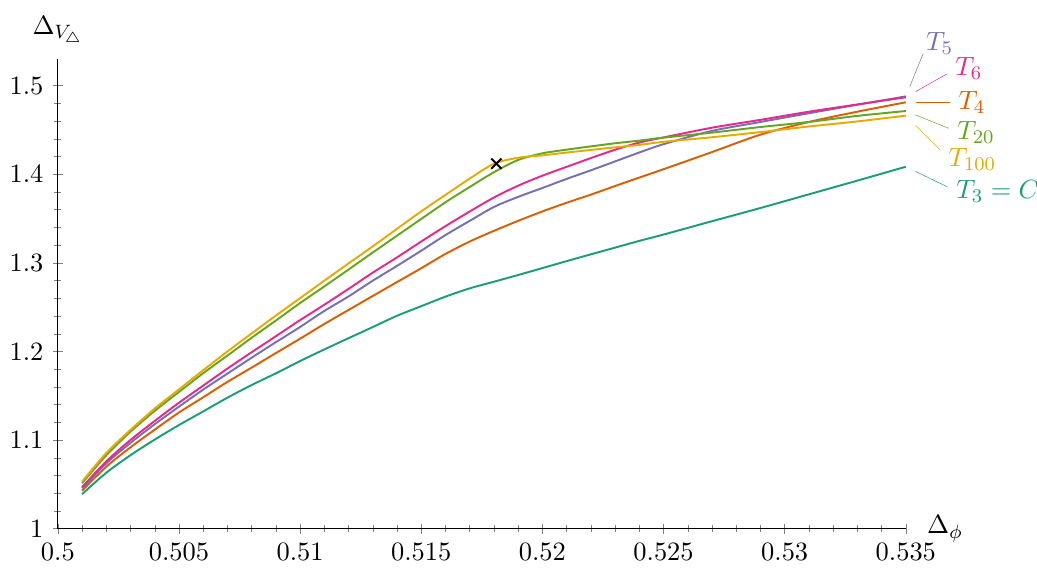
Figure 12 . Upper bound on the dimension of the (cid:12)rst scalar operator in the V + (cid:30) (cid:11) (cid:2) (cid:30) (cid:12) OPE as a function of the dimension of (cid:30) . Areas above the curves are excluded in the corresponding theories. The x-marker indicates the position of the decoupled Ising theory.